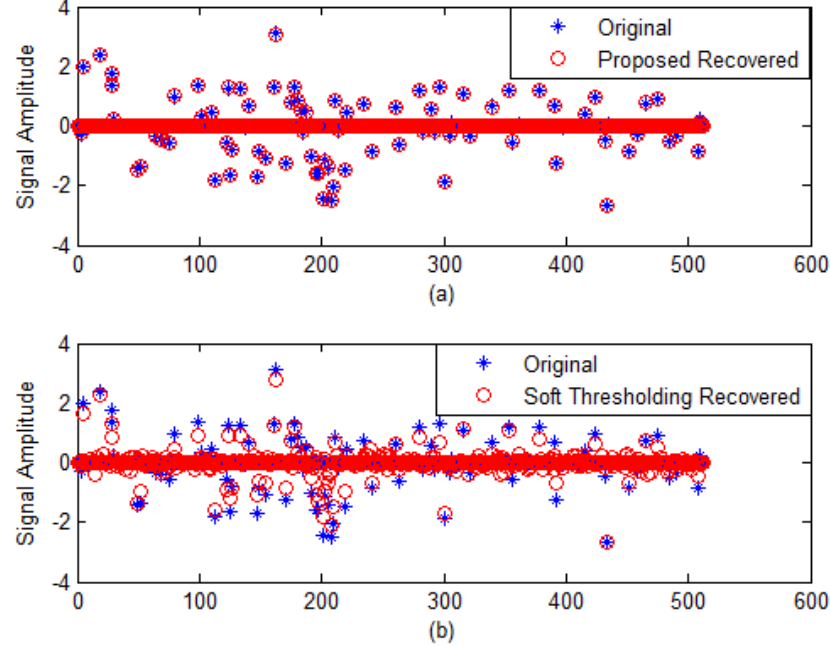
Figure 6. Sparsity effect on successful recovery achieved by the soft thresholding and proposed al- gorithm. The proposed algorithm performs much better even with higher sparsity level as com- pared to the soft thresholding technique.